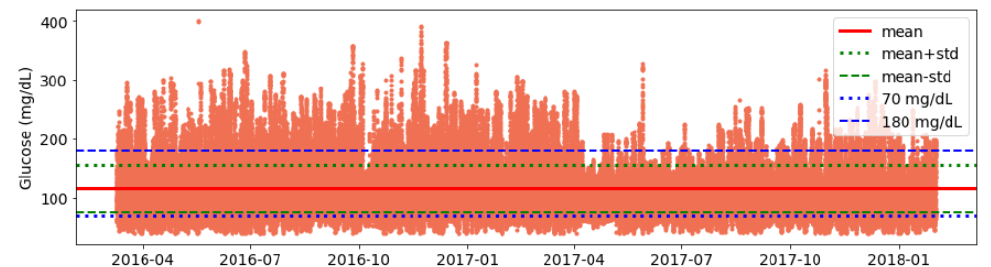
Figure A1. Visualisation for Glucose Data for an Open-Source AID